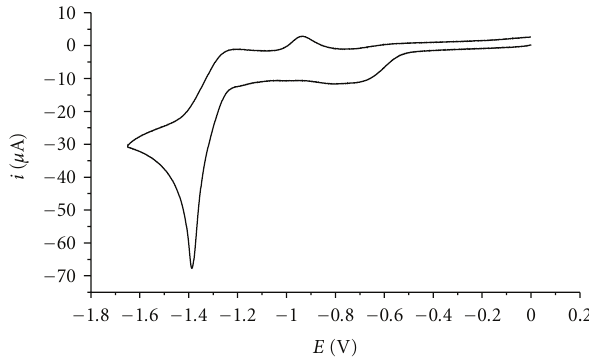
Figure 2: Reduction voltammogram of acifluorfen. Acetonitrile,